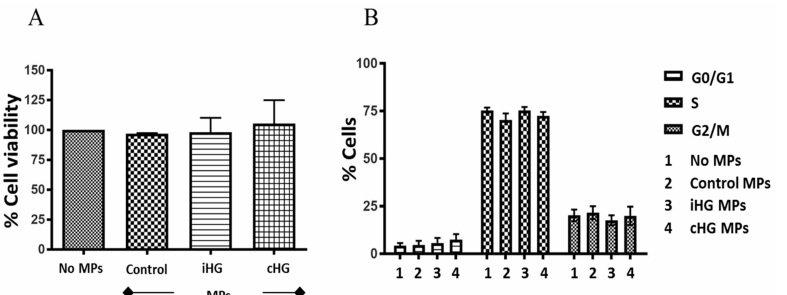
Figure 1. High glucose-derived microparticles (MPs; 10 µ g / mL) do not a ff ect the cell viability and cell cycle progression of naïve renal proximal tubular cells. ( A ) Cell viability determined using alamar blue assay; and ( B ) Cell cycle analysis performed using Tali TM cell cycle assay kit. Values were expressed as mean ± SEM; n = 3–4. iHG: Intermittent high glucose; cHG: Continuous high glucose.